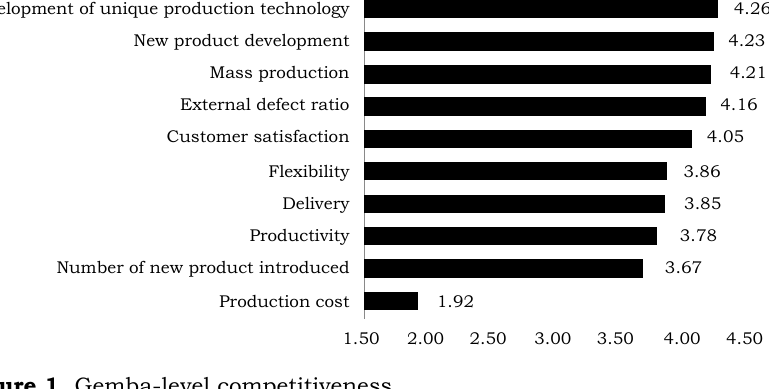
Figure 1. Gemba-level